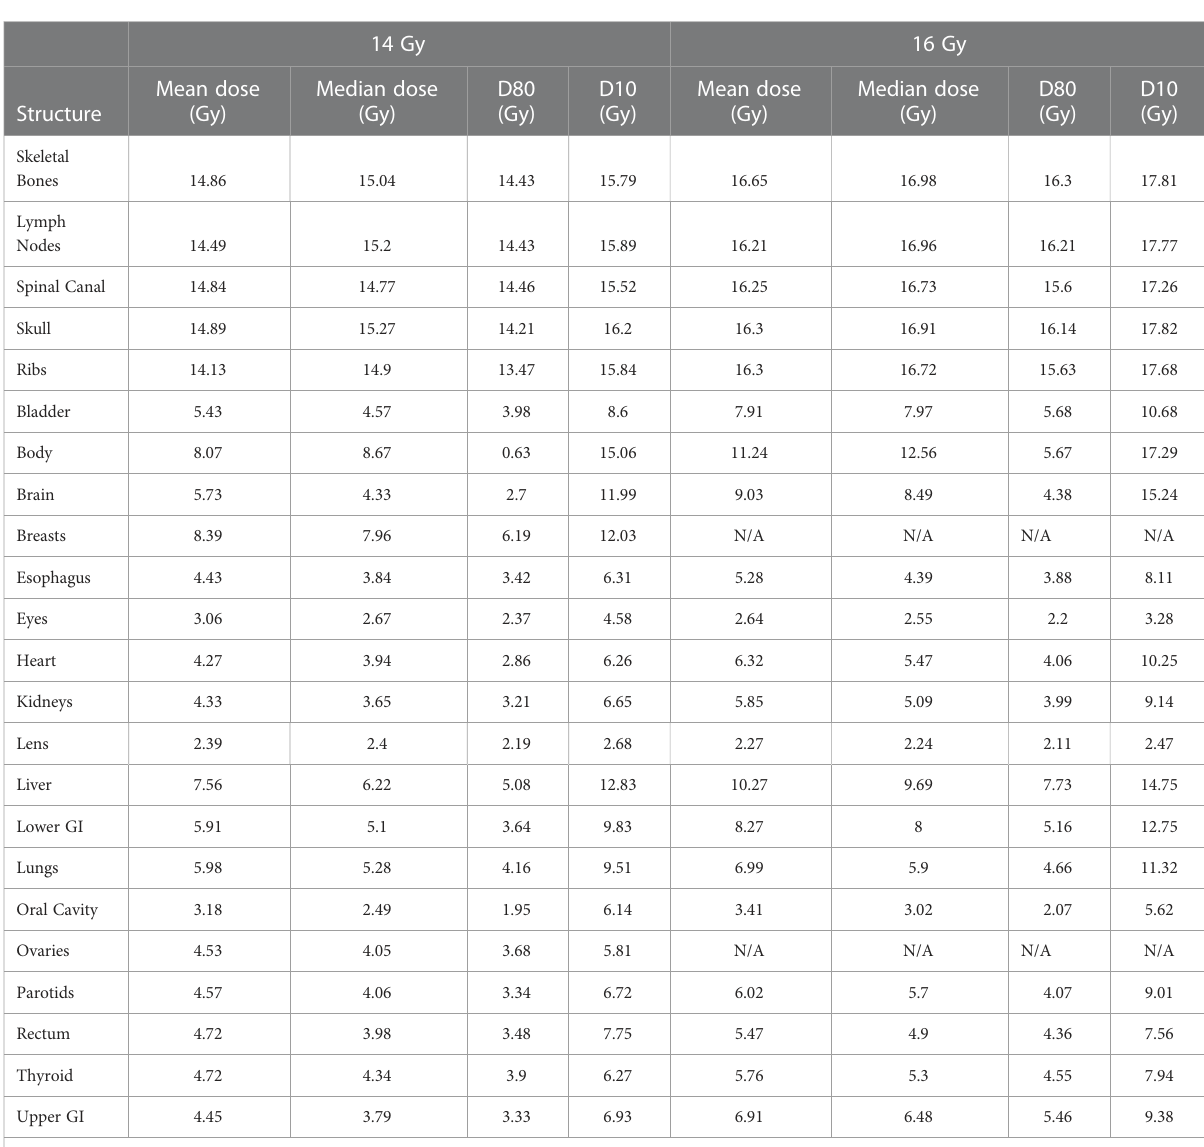
TABLE 4 Dose statistics for patients treated to 14 and 16 Gy. 14 Gy 16